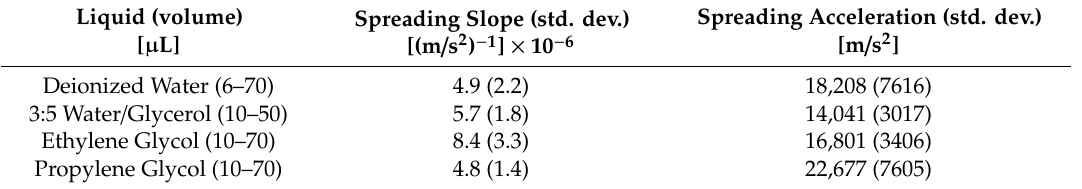
Table 3. The spreading slope ((d / d i ) / a m ) and spreading acceleration (a s ) for all 4 liquids. Liquid